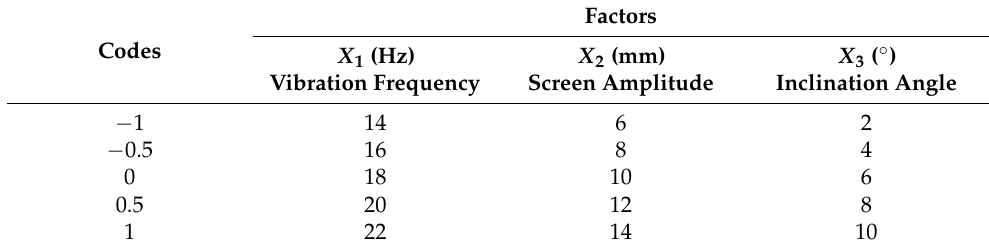
Table 3. Codes of experimental